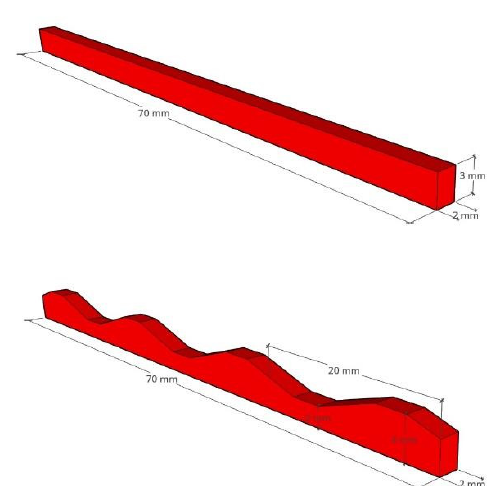
Figure 1. Examples of discrete 3D printed reinforcement bars: (top) with a rectangular cross ‐ section; (bottom) with a "wavy" profile intended to increase mechanical interlocking [17] , in analogy to plain and ribbed steel rebars. Farina et al. [18] investigated the possibility of printing discrete reinforcement bars using PolyJet 3D printing of liquid photopolymers through the Objet500 Connex printer. As